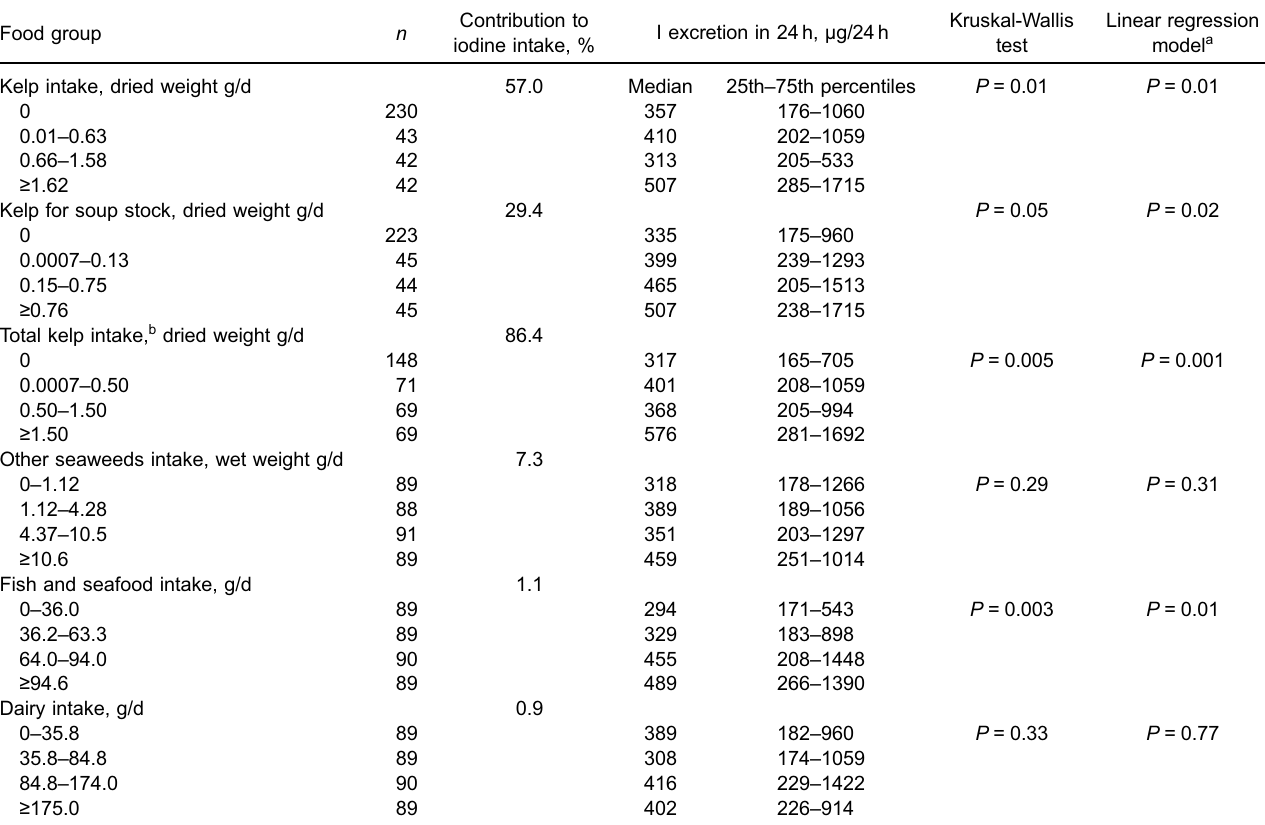
Table 5. Dietary predictors of iodine excretion in 24-hour urine samples in 357 Japanese